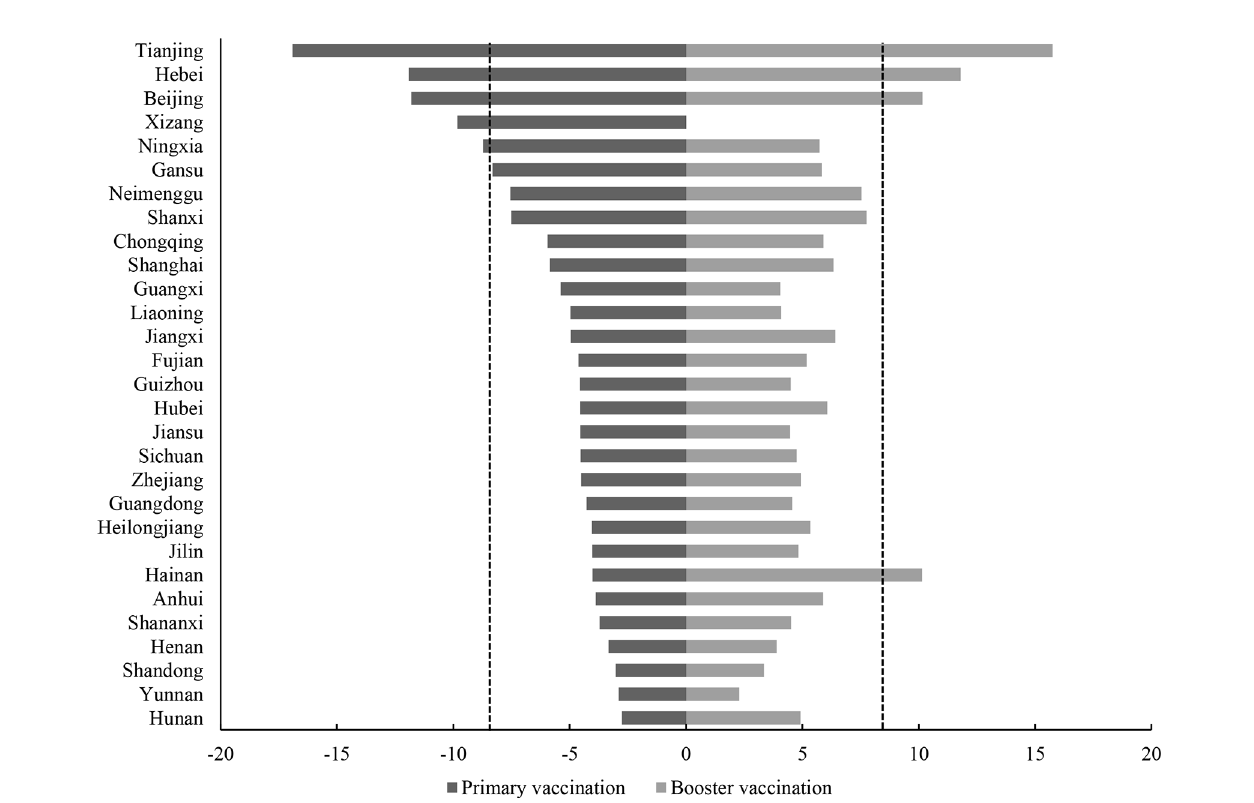
FIGURE 2 | Age- and sex-standardized prevalence of COVID-19 vaccine hesitancy by province in primary vaccination (left) and booster vaccination (right). Qinghai and Xinjiang province were not